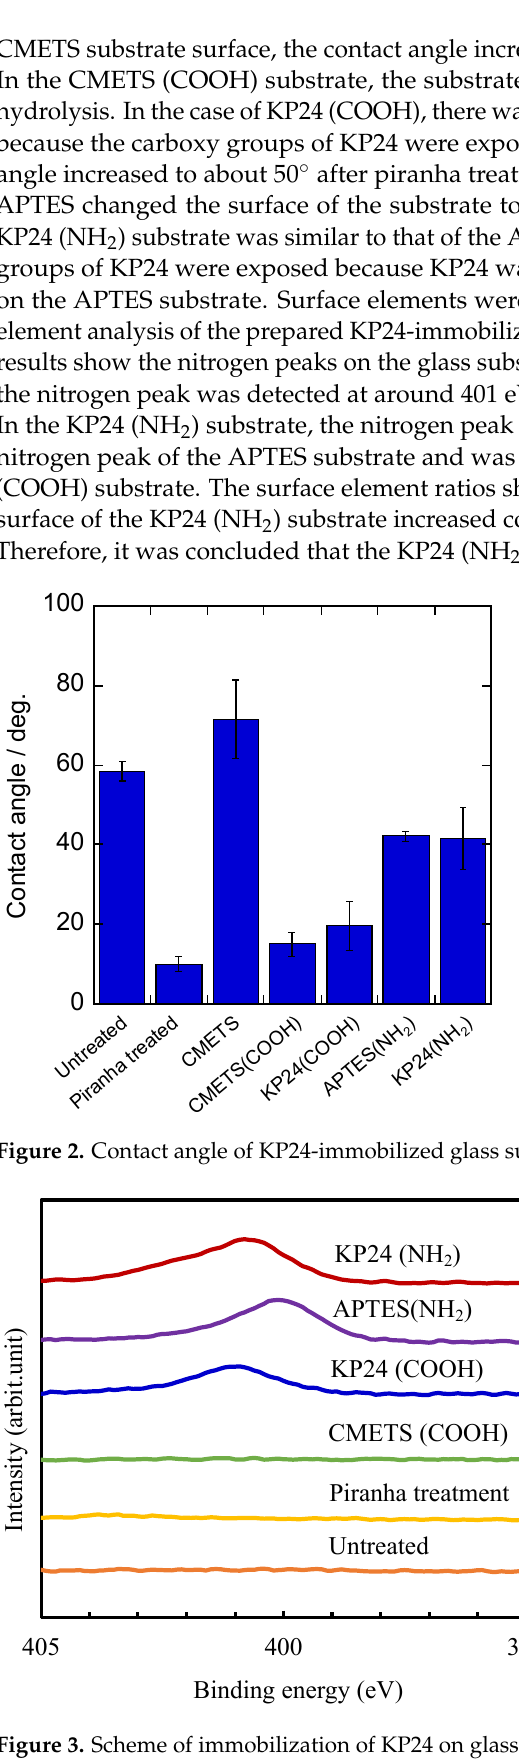
Figure 3. Scheme of immobilization of KP24 on glass surface by silane coupling agent.